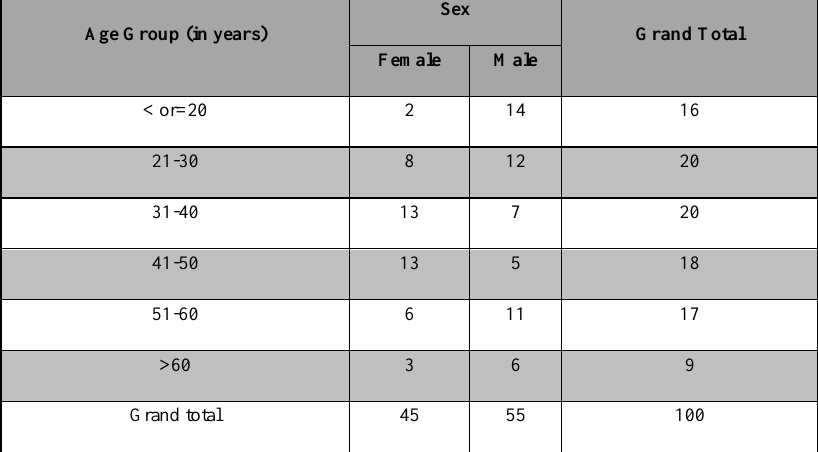
Table 1. Age and sex distribution of salivary gland lesions (n=100).